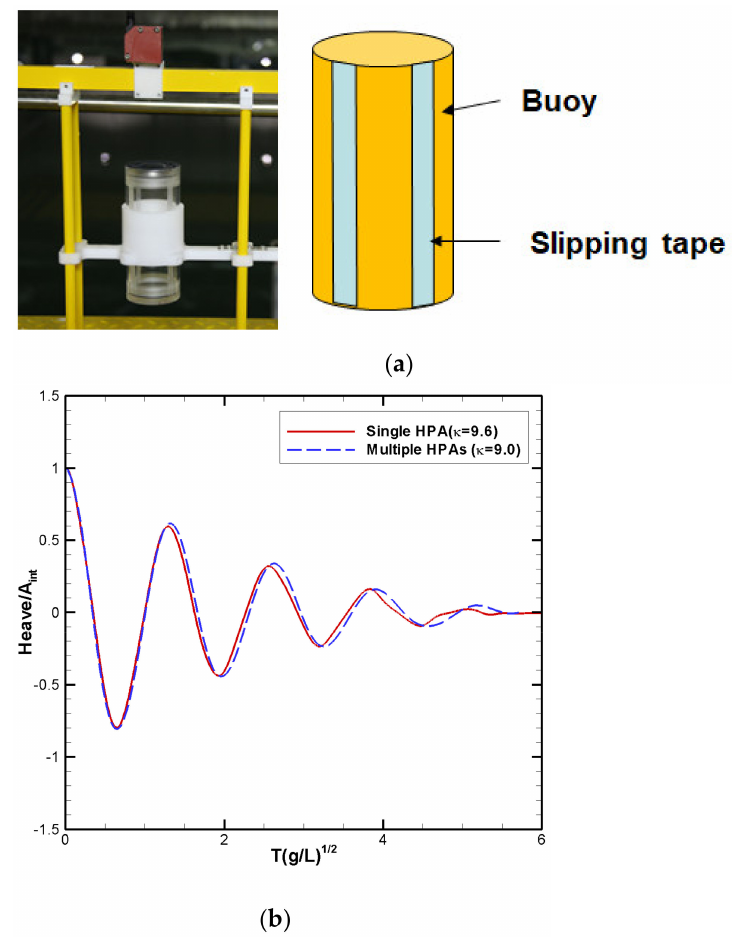
Figure 10. Free decay of HPA; ( a ) matching of HPA damping; ( b ) free decay of HPA connected to large semi-submersible.